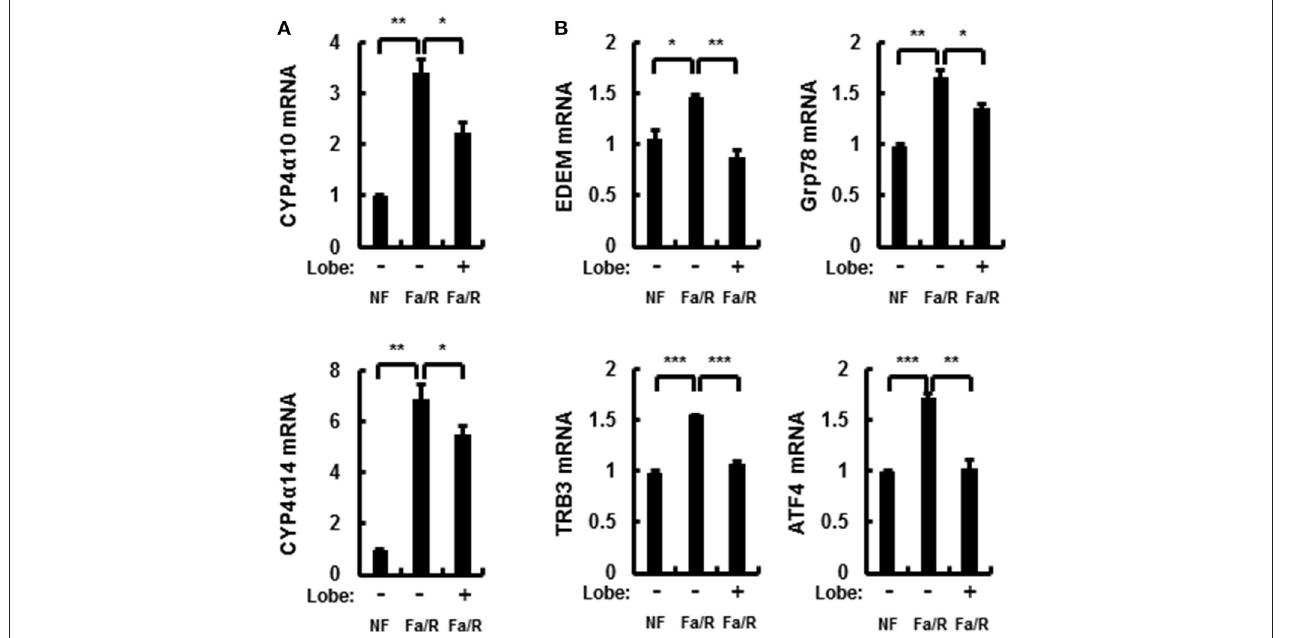
FIGURE 2 | Lobeglitazone inhibits ER stress and fatty acid ω -oxidation upon acute lipogenic stimulus in mice. (A,B) Mice were maintained in a non-fasted state (NFa) ( n = 8) or fasted overnight and then refed a high-carbohydrate, fat-free diet (Fa/R) with vehicle ( n = 9) or lobeglitazone ( n = 9). The isolated total RNA was subjected to qR, Grp78, TRB3, and ATF4 mRNAs (B) . The data are expressed relative to the corresponding value for non-fasted mice and are the mean ± standard error for eight or nine mice in each group. * p < 0.05, ** p < 0.01, and *** p <